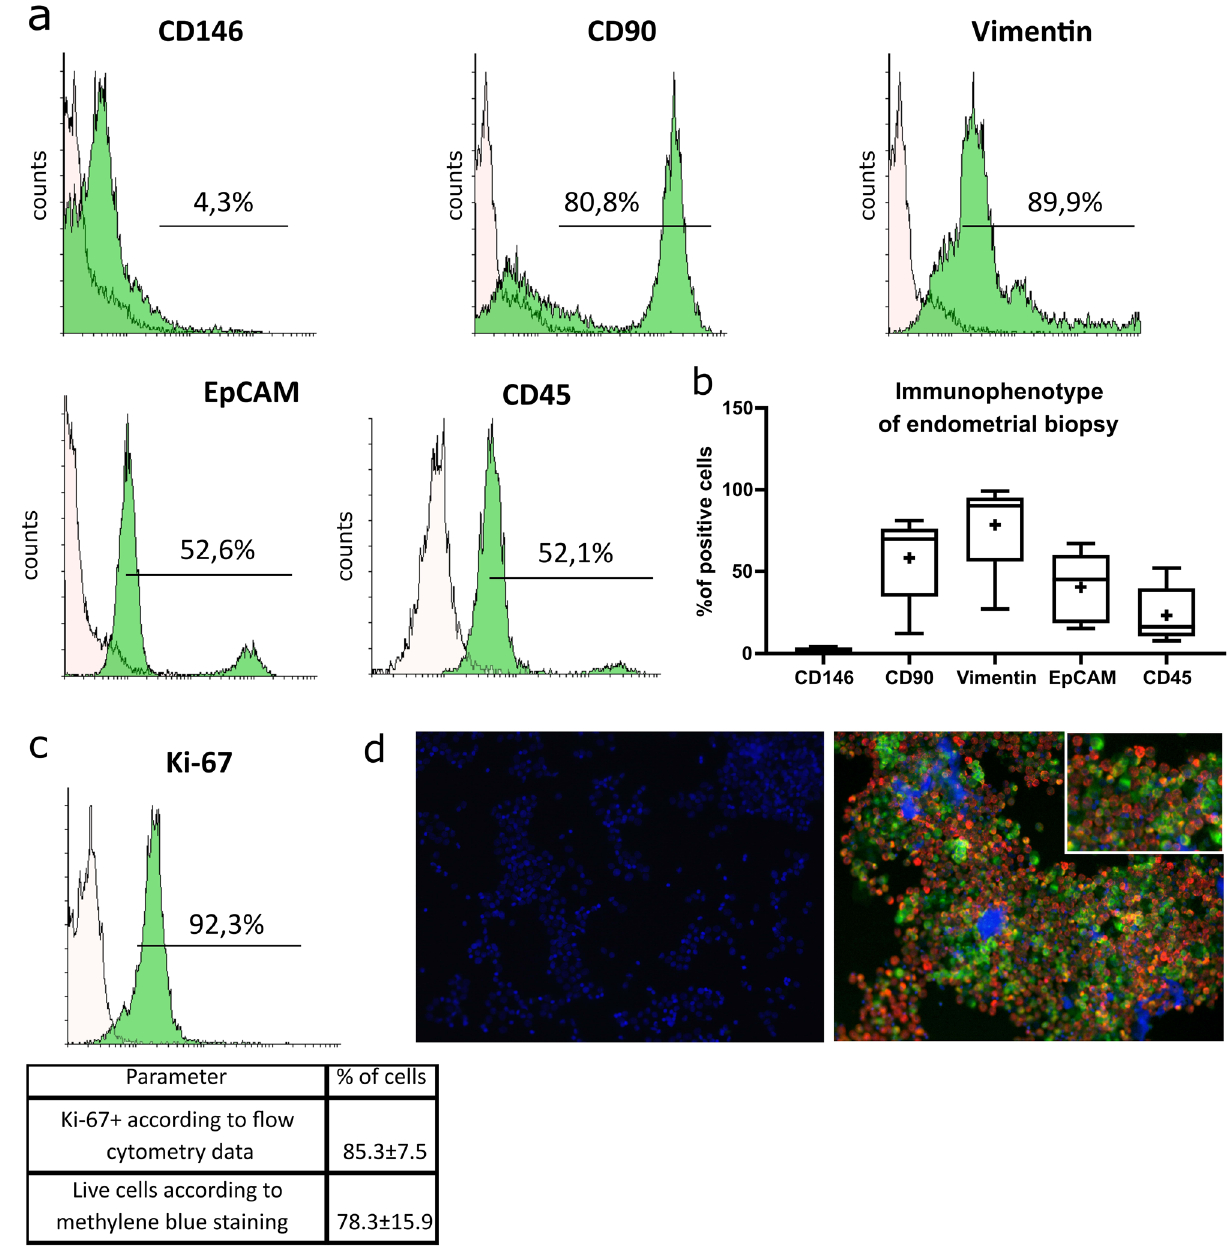
Figure 3. Immunochemical characterization of the minimally manipulated cell products isolated from endometrial biopsies. ( a) representative flow cytometry histograms with indicated percentages of CD146, CD90, vimentin, EPCAM and CD45 positive events; the pale-filled curves correspond to control staining. ( b) a boxplot of cells positivity stained by markers. c , cell viability evaluation by anti-Ki-67 flow cytometry and methylene blue assay. ( d) immunocytochemistry analysis with DAPI counterstaining for cell nuclei (blue): negative control (secondary antibodies only, left image) and staining with antibodies (right image) to vimentin (red) and EPCAM (green), magnification × 200. Software: ( a,c) Flowing Software 2.5.1 RRID: SCR_015781, B, GraphPad Prism RRID: